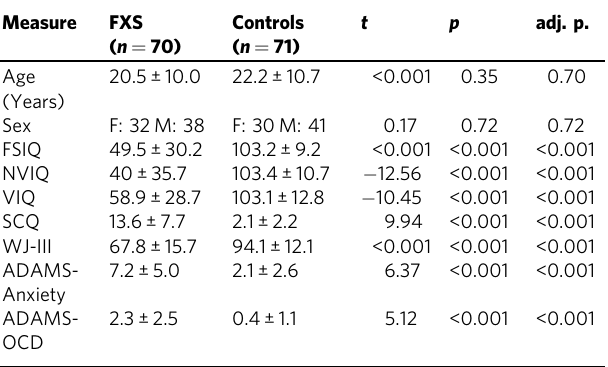
Table 1 Demographic and clinical features of the EEG dataset.